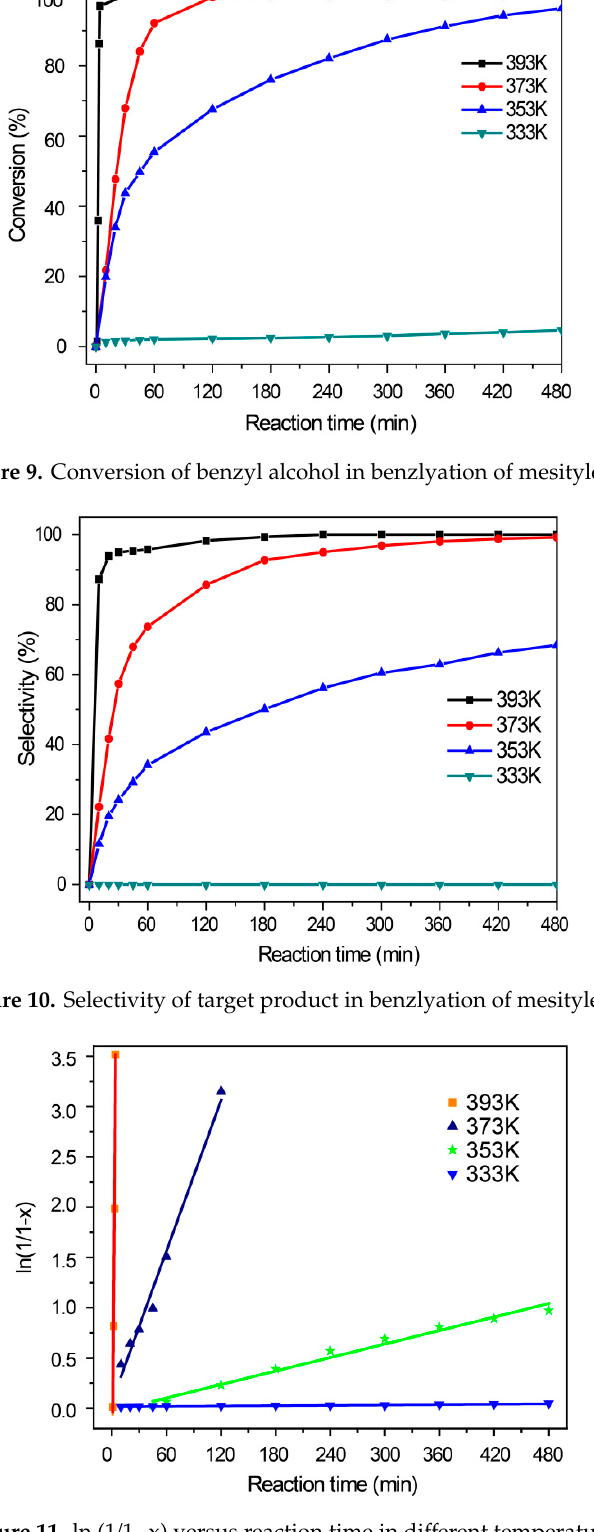
Figure 12. The linear Arrhenius graph of benzylation of mesitylene on H β -3. 2.4. Recycling of the Catalyst